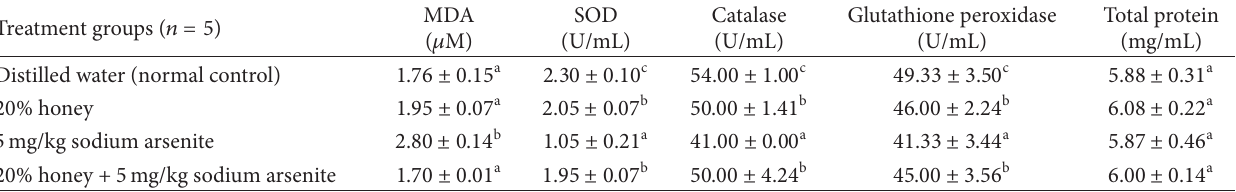
Table 2: Redox sensitive biomarkers level in rat lung tissues due to Acacia honey and sodium arsenite administration. Treatment groups ( 𝑛 = 5